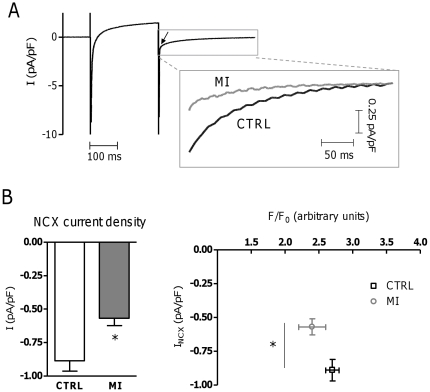
NCX in myocytes from the area adjacent to MI.A. NCX function was measured as the tail current upon repolarization to −70 mV (arrow) after a step to +10 mV in CTRL and MI. B. Averaged NCX current density in CTRL (Npigs = 9, ncells = 30) and MI (Npigs = 7, ncells = 19), with [Ca2+]i measured simultaneously. * denotes P<0.05.